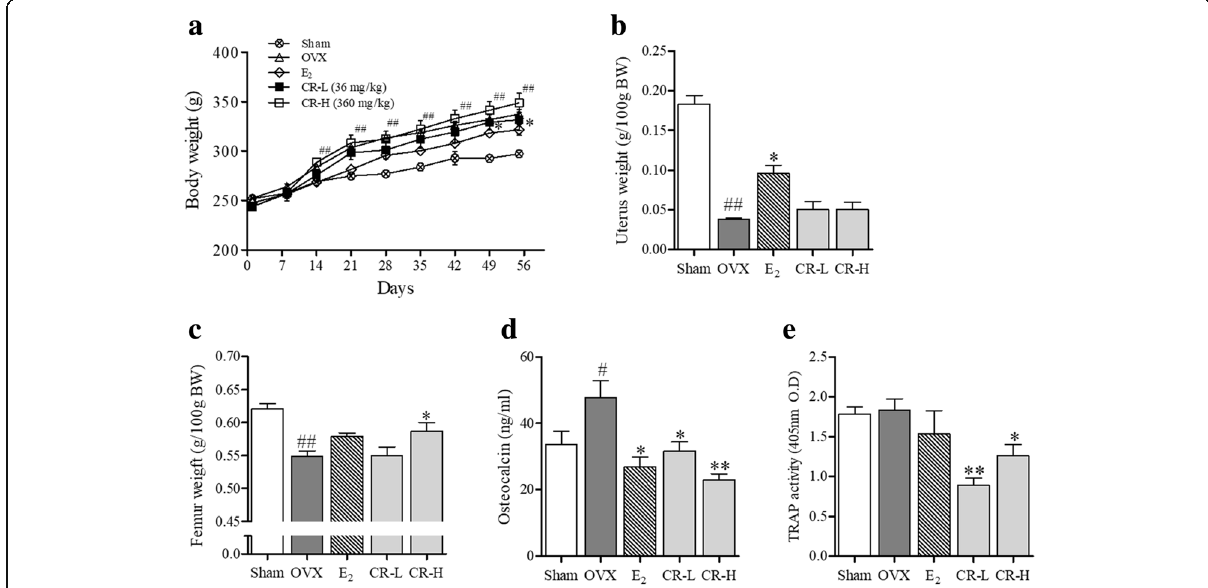
Fig. 7 Effect of CR on the OVX-induced osteoporosis rat-model. a Weekly body weight of OVX-induced SD-rats, b the rats were sacrificed after weighing the uterus and c tibia. d Osteocalcin and e TRAP activity on serum were measured. Columns and error bars represent the mean ± S. E of eight independent experiments. ## p < 0.01 compared with the Sham and * p < 0.05 compared with OVX